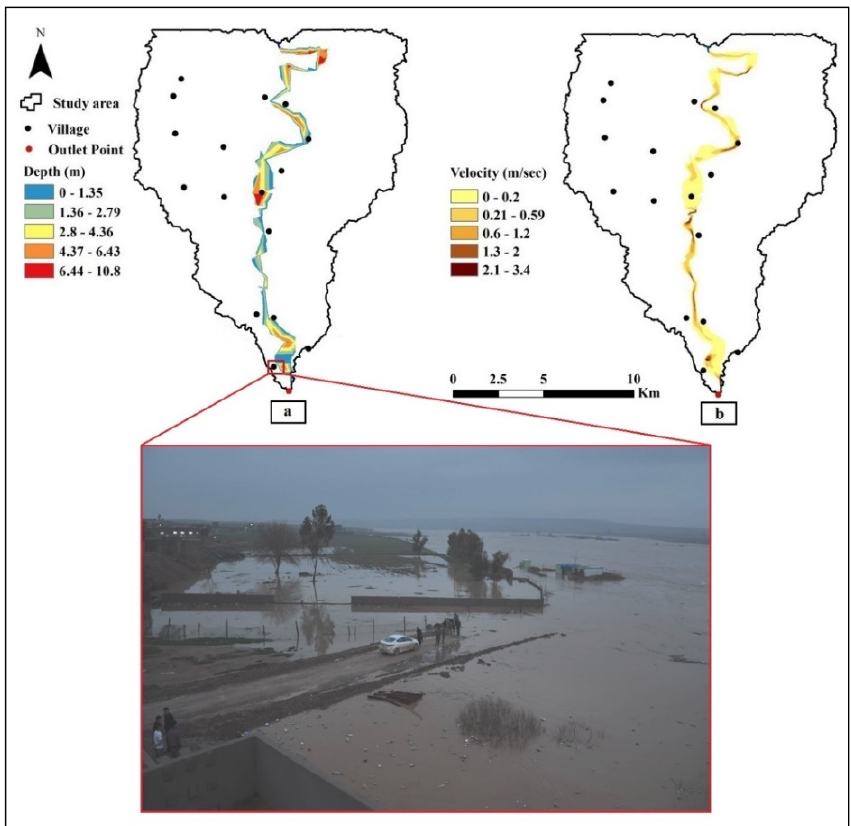
Figure 10. ( a ) Floodplain depths map; ( b ) Water current velocity map.